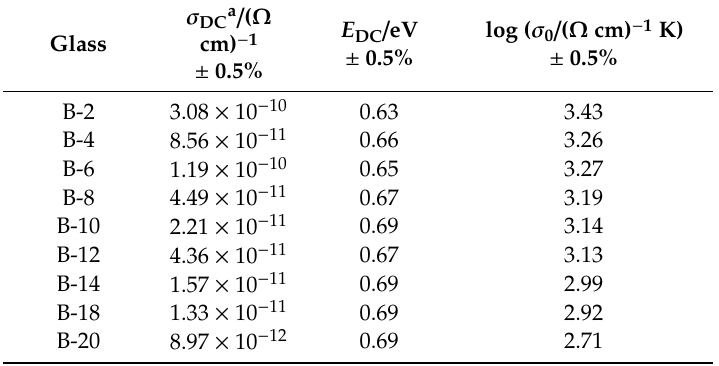
Table 2. DC conductivity, σ DC , activation energy, E DC and pre-exponential factor, σ 0 , for all studied glasses.